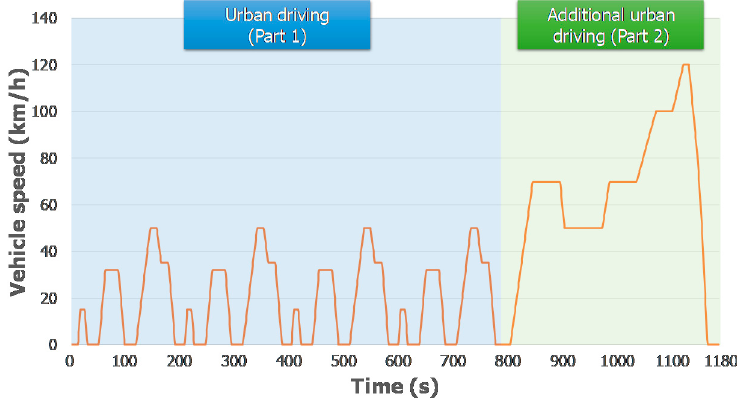
Figure 3. New European Driving Cycle (NEDC) test cycle.